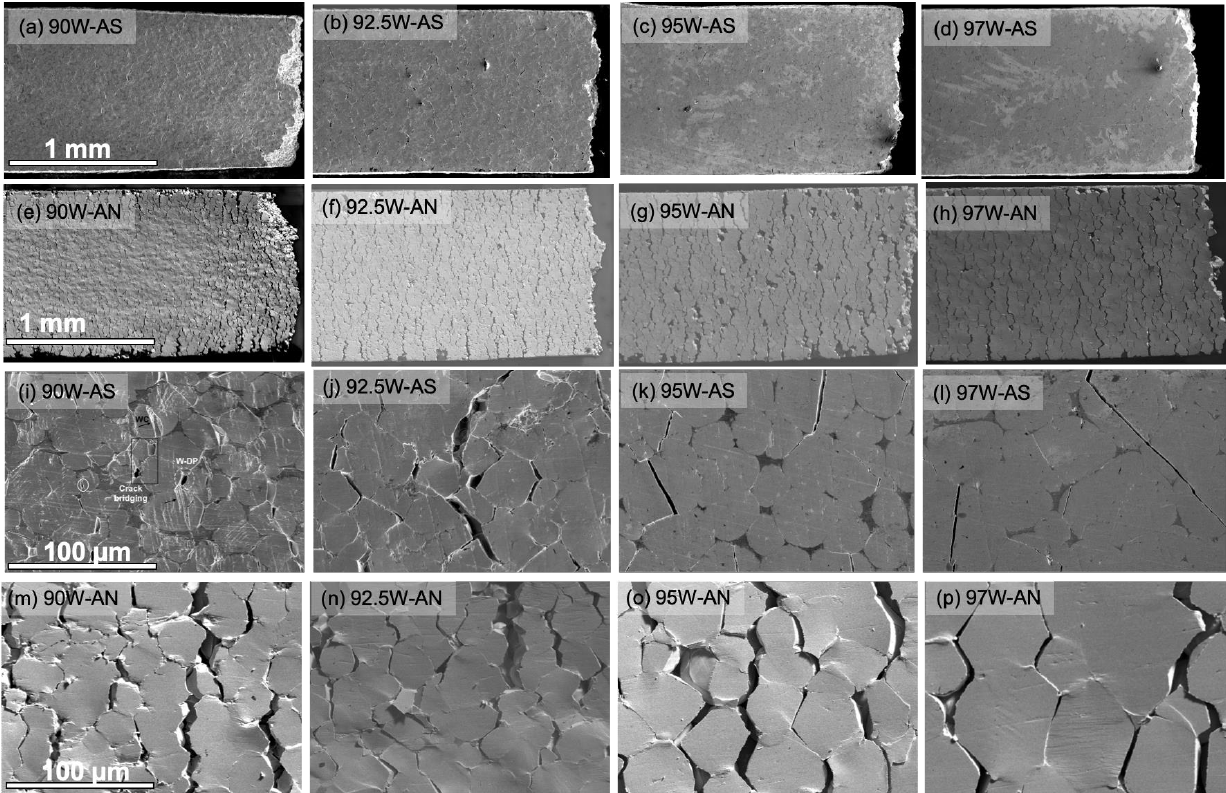
Figure 6. SEM micrographs on the gauge section surface of the tensile specimens for ( a – d ) AS and ( e – h ) AN WHAs for 90, 92.5, 95, and 97W, respectively. Higher magnification SEM images for respective WHAs are shown in ( i – l ) AS and ( m – p ) AN conditions. The scale bars for the respective rows are shown in the first column.